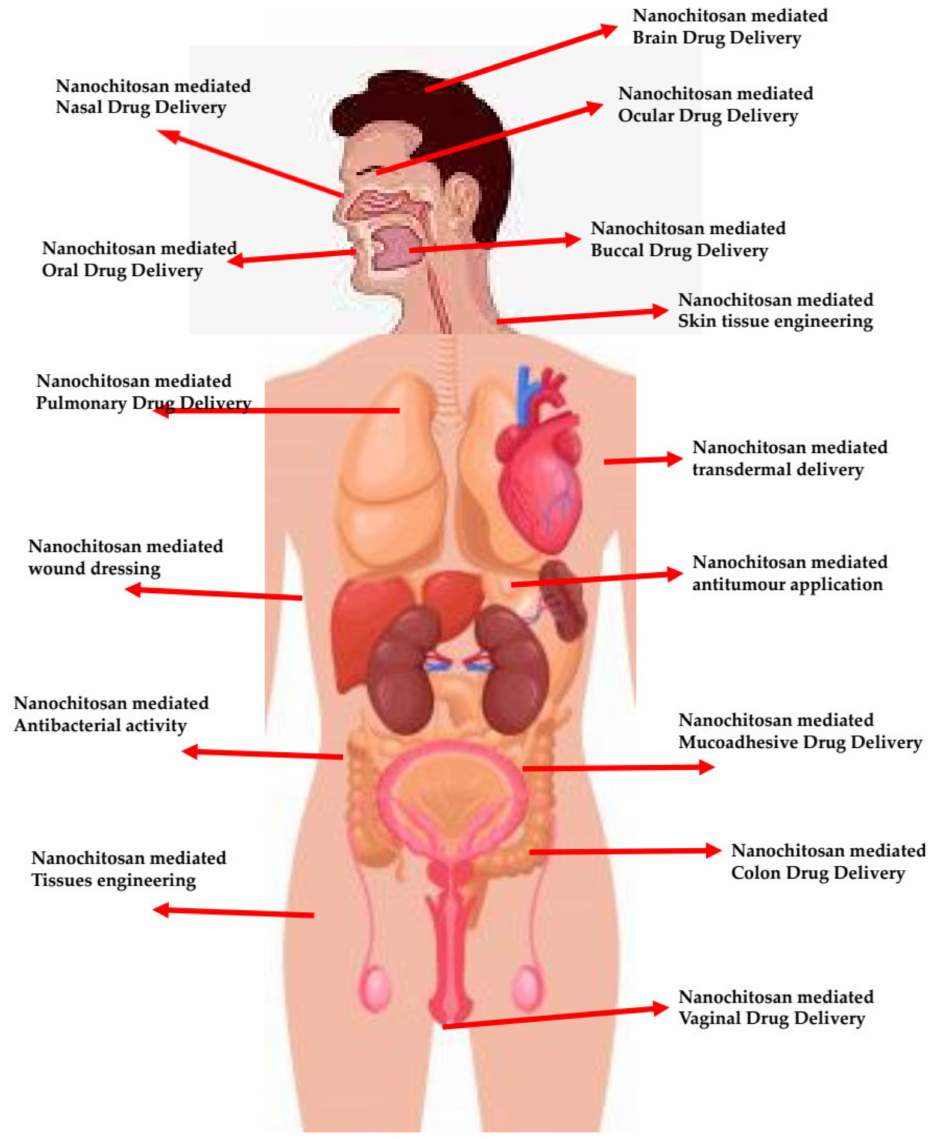
Figure 1. Overview of chitosan nanomaterial-based biomedical